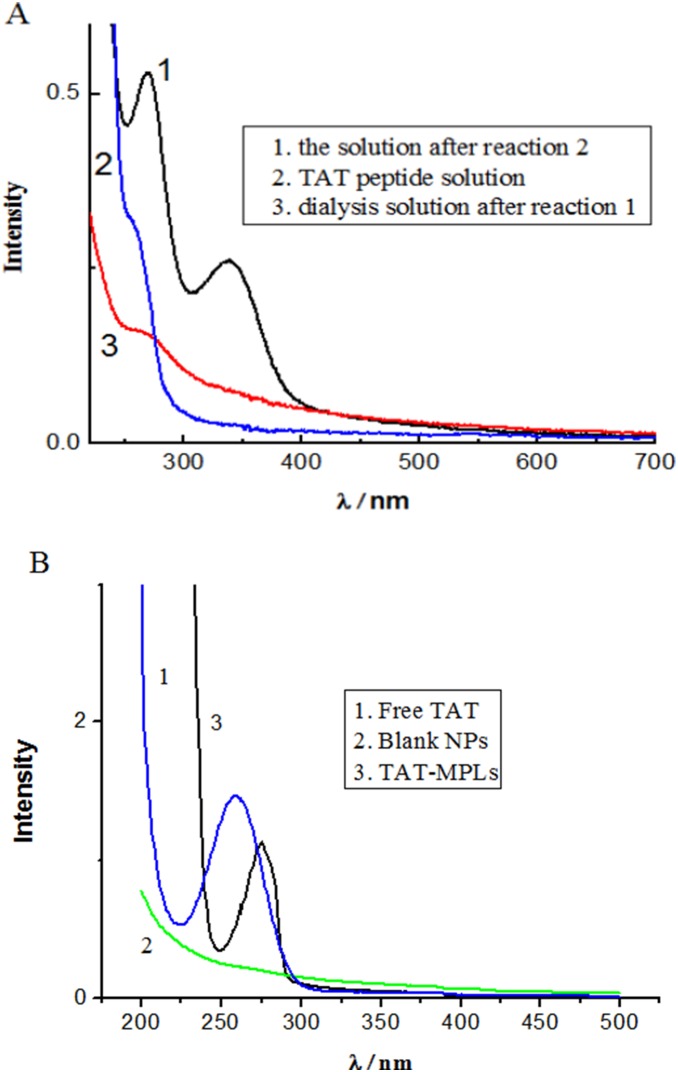
UV/Vis spectra.(A) UV/Vis spectra of the reaction solutions (conjugation of TAT to MPLs). (B) UV/Vis spectra of blank NPs and TAT-MPLs.